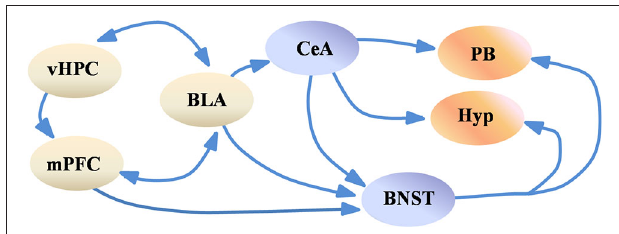
FIGURE 1 | Simplified scheme of the anxiety network . Highly processed sensory and contextual information from the vHPC and the mPFC is integrated by the BLA, which in turn may activate the CeA and the BNST. The CeA and the BNST project to the hypothalamus and to brain stem nuclei such as the PB, which modulate various features of anxiety, such as avoidance of open spaces and changes in respiration rate. For simplification purposes subregions of the BNST, CeA, Hypothalamus and mPFC are not shown. Abbreviations: BLA: basolateral amygdala, BNST: bed nucleus of the stria terminalis, CeA: central amygdala, Hyp: hypothalamus, mPFC: medial prefrontal cortex, PB: parabrachial nucleus, vHPC: ventral